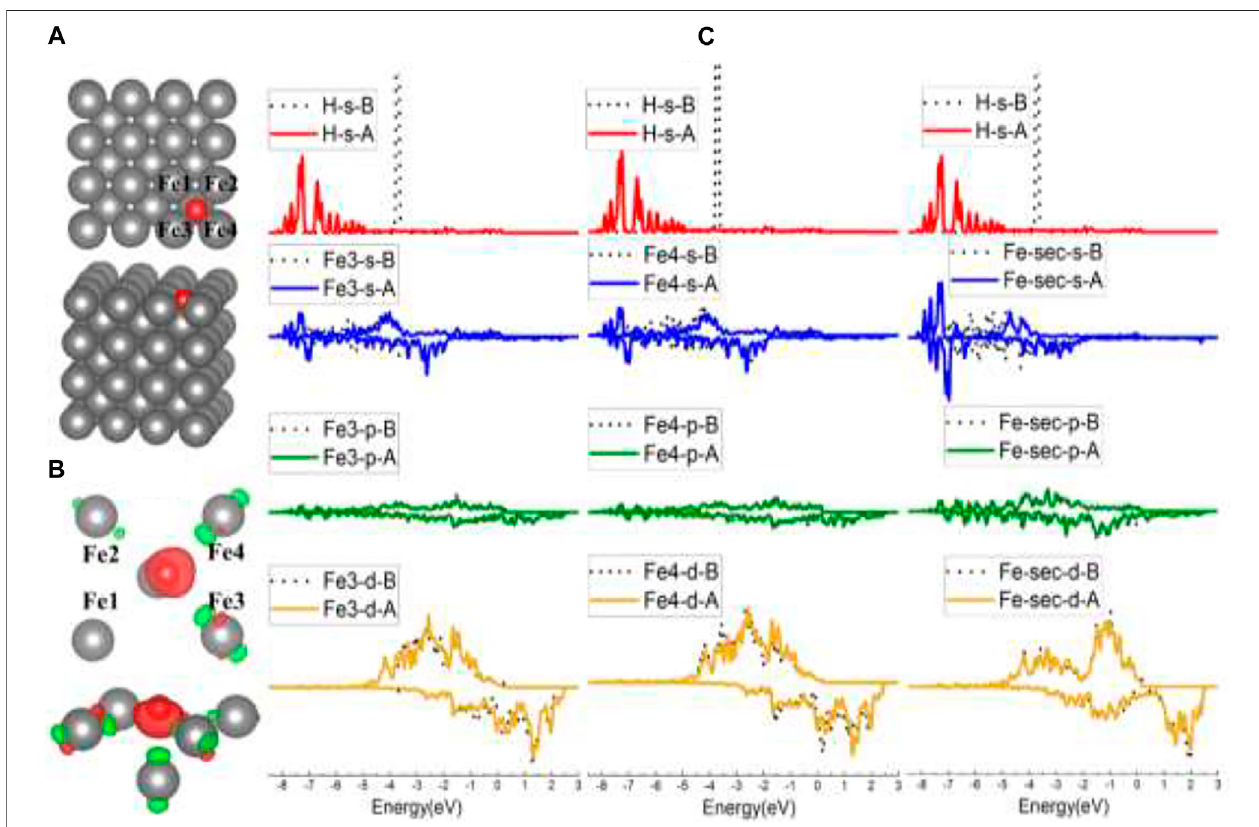
FIGURE 4 | The optimized structure, charge density difference, and DOS of the four-fold site after the hydrogen atom is adsorbed on the Fe (100) surface: (A) top and side view of the H-slab structure, (B) charge density difference (the isosurface of charge difference is 0.007 electrons/Bohr 3 ), red color represents charge accumulation, and green color represents charge depletion, and (C) DOS before and after H atom adsorption, the black dotted lines represent s / p / d orbitals before H atom adsorption, and B/A represents before and after, respectively.